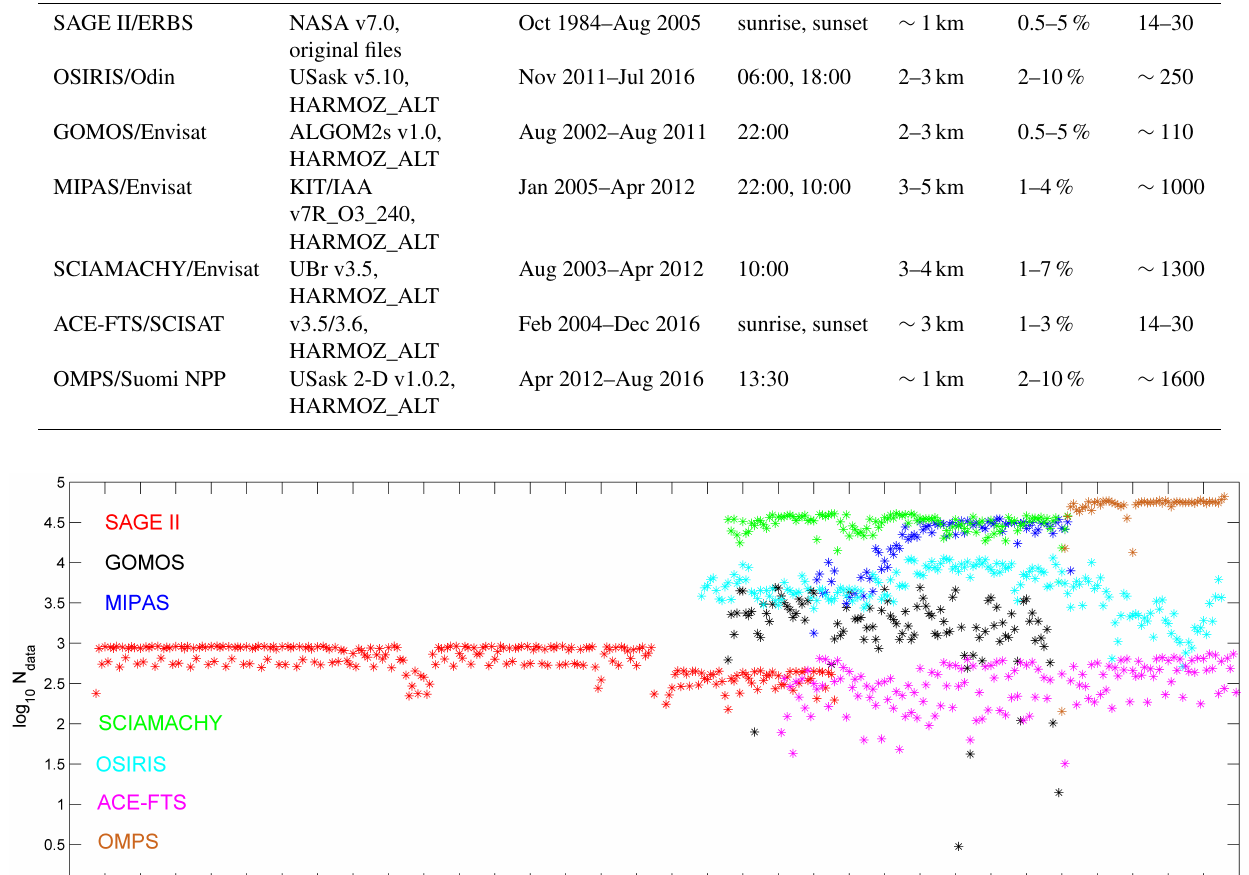
Figure 1. Monthly data volume (logarithm of number of measurements).